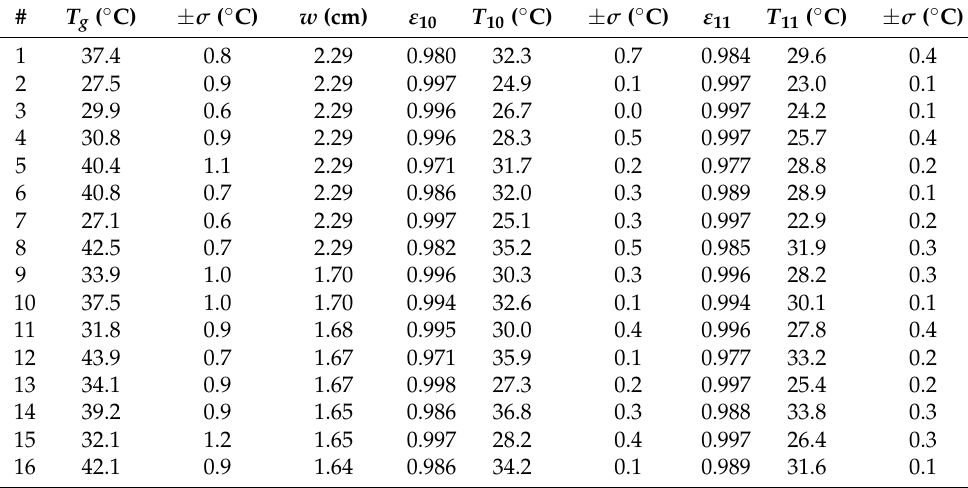
Table 3. Average values of the ground-measured temperatures ( T g ). Standard deviation ( σ ) accounts for the spatial and temporal variability in each plot. Total precipitable water ( w ) was obtained following the SBAC interpolation methodology. Includes extracted emissivity values ( ε 10 and ε 11 ) and satellite brightness temperatures ( T 10 and T 11 ), together with their standard deviation ( σ ) corre- sponding to 3 × 3 pixel averages, for cases labeled in Table